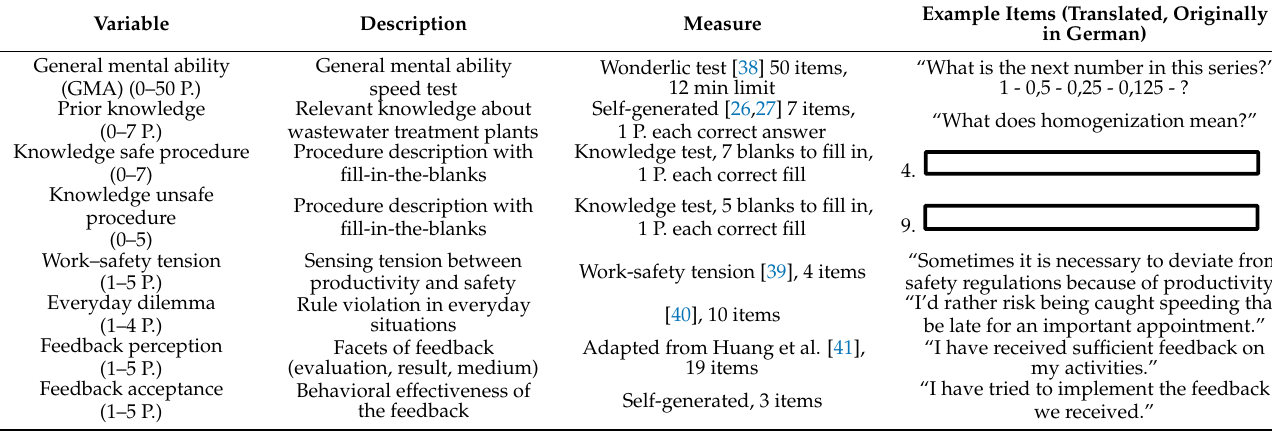
Table 2. Descriptions of questionnaires used to collect information regarding control variables.